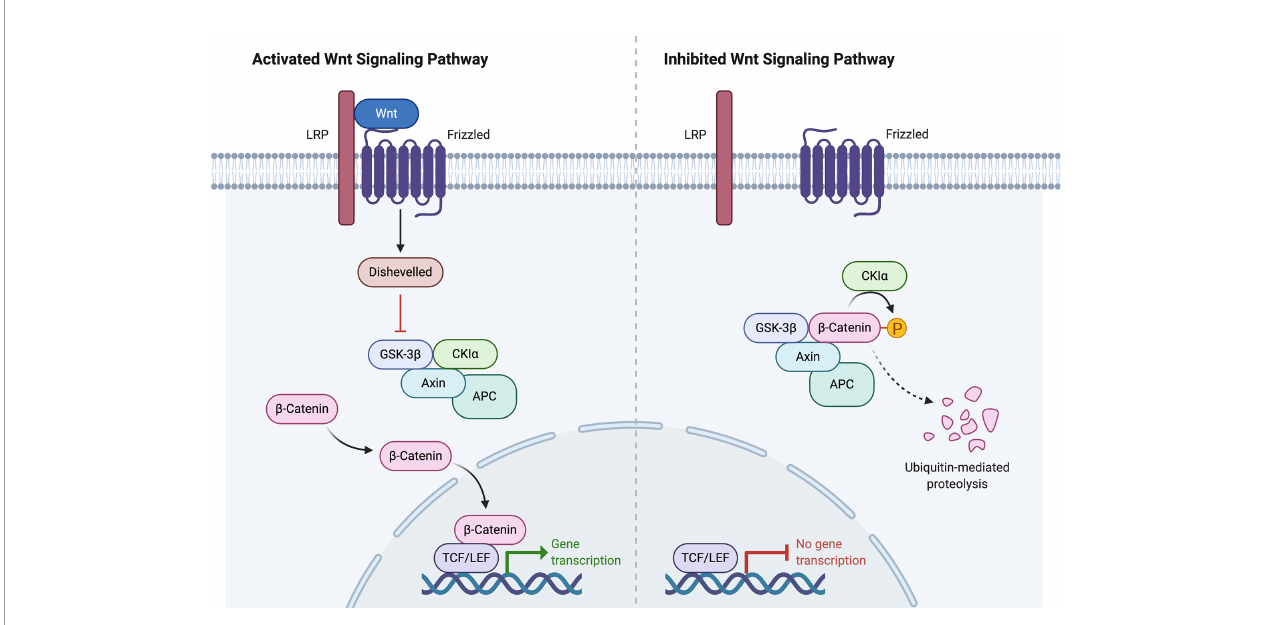
FIGURE 2 | Wnt signaling pathway activation and inhibition. Created with